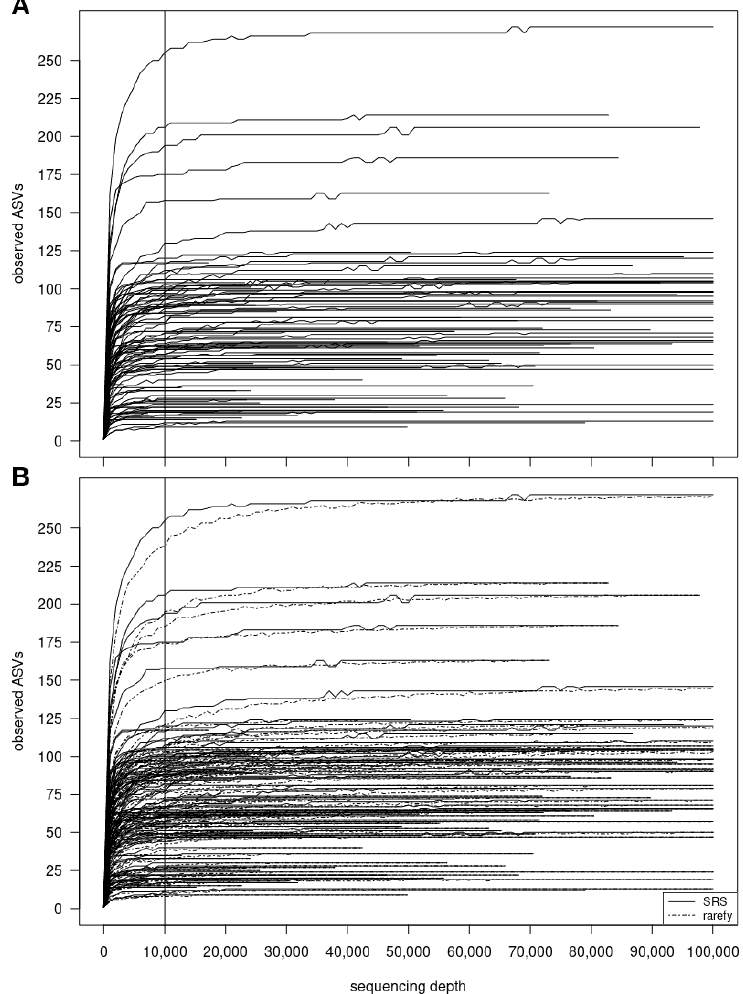
Figure 2. ( A ) SRS curves and ( B ) comparison of SRS curves and repeated rarefying (10 repeats) using the “ richness ” metric ( SRScurve -function of the ‘SRS’ R package version 0.2.2). The vertical black solid line indicates the chosen number of counts (10,000) to which all samples will be normalized (C min ).